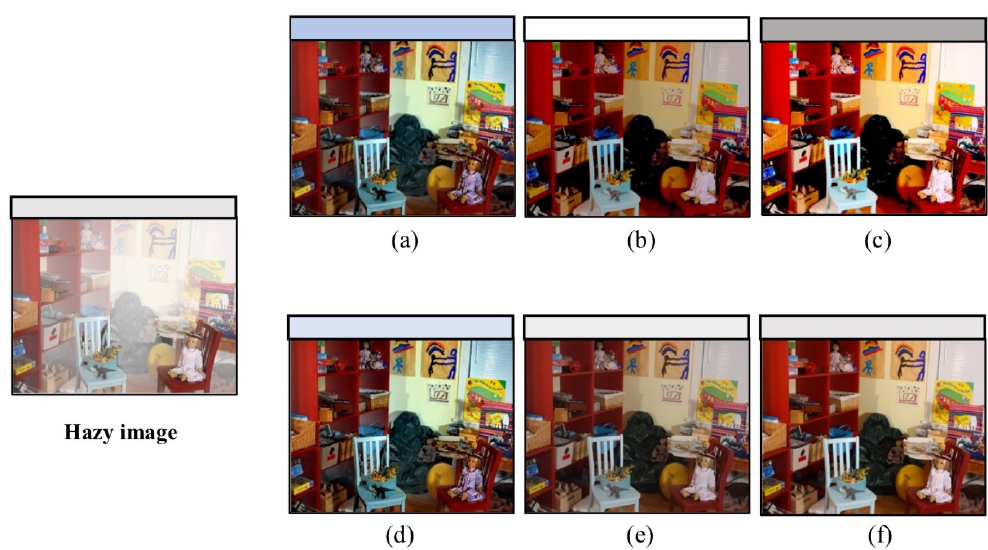
Figure 6. Visual comparison of AL estimation results for haze removal: ( a ) Zhu’s method [20]; ( b ) Cai’s method [26]; ( c ) Sulami’s method [38]; ( d ) Salazar-Colores’s method [35]; ( e ) Haouassi’s method [36]; and ( f ) the proposed